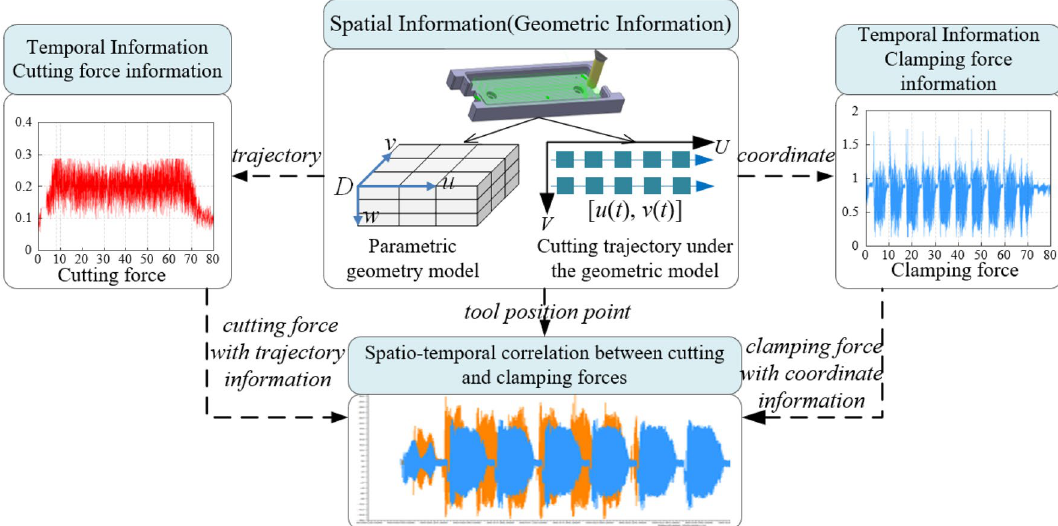
Figure 3. Schematic diagram of spatio-temporal correlation between cutting and clamping of cutting force and clamping force. Secondly, the corresponding tool trajectory information is discrete into tool position points, and the cutting force is associated with the tool trajectory according to the tool position point information, and the clamping force is associated with the fixed coordinate information on the two-dimensional plane. Finally, the information of two types of unsynchronized forces is associated through the time interval of adjacent tool position points , so as to realize the association of the two in spatial and temporal terms.